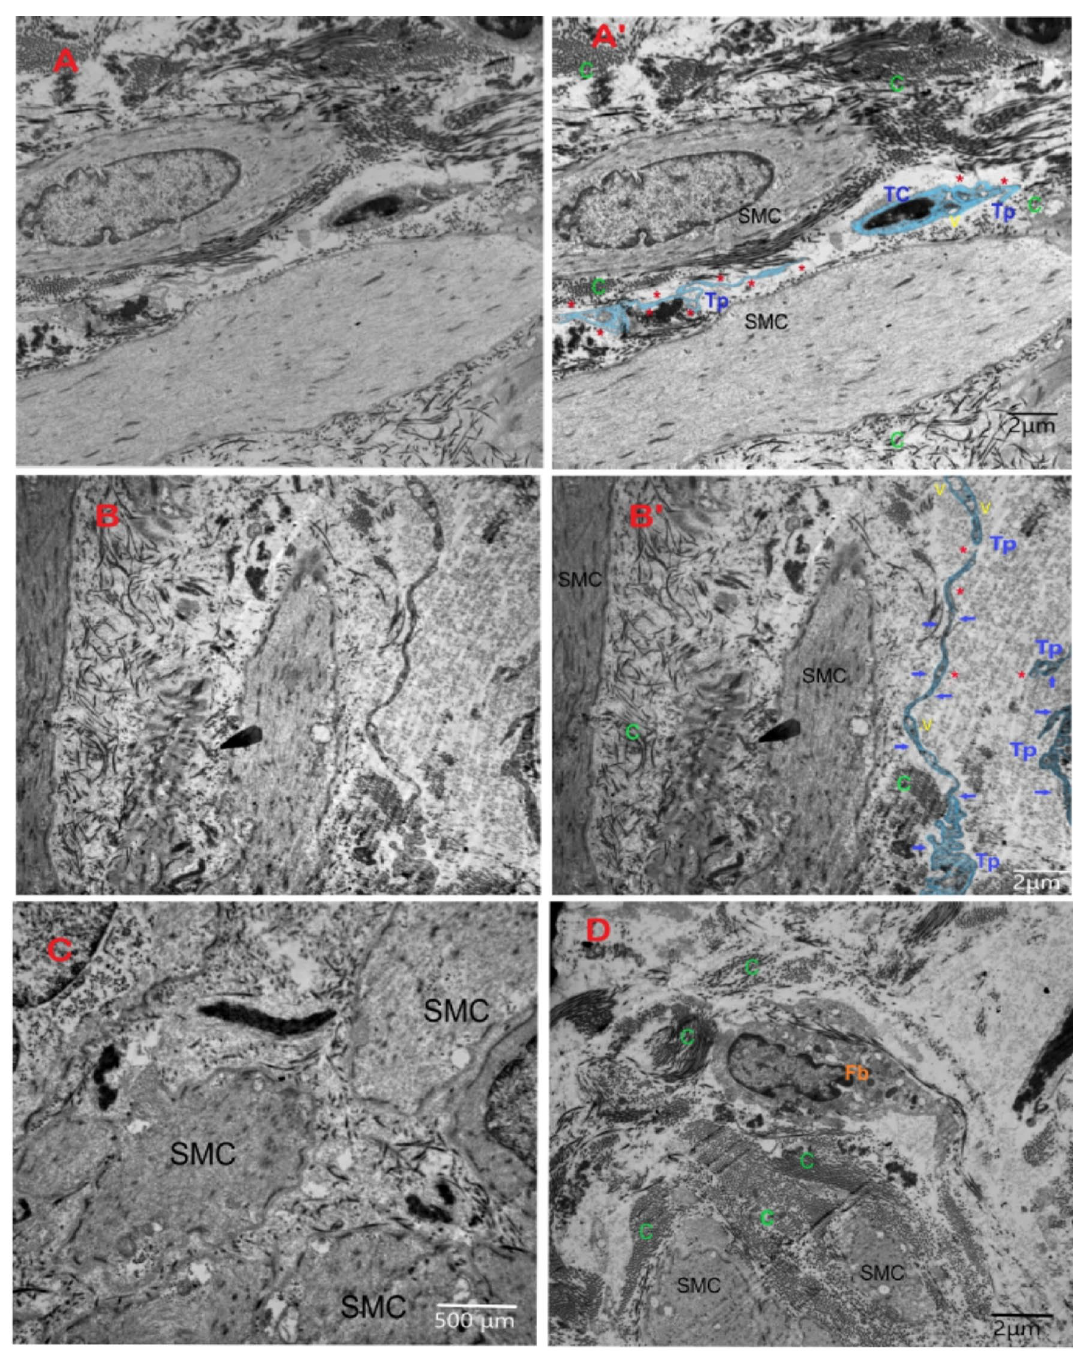
Figure 4. TEM microgram of submucosa and muscularis propria of normal-appearing tissue of urinary bladder with NMIBC. (A , A ′ ) ( A : original findings), ( A’ : digitalized image) showing TC with its distinct nucleus, and Tp (red Asterix) appearing thin, tortuous, and having numerous vesicles (V). TC and Tp are insinuated between two smooth muscle cells (SMC) and abundant collagen (green C). (Scale bar 2 μm). (B , B ′ ) (B: original findings), ( B ′ : digitalized image) showing Tp (blue short arrows and red Asterix) that has numerous vesicles (yellow V) and is attached to the smooth muscle cell (SMC) and collagen (green C). (Scale bar 2 μm). (C , D) showing smooth muscle cells (SMC) with condensation of collagen (c) between smooth muscle cells (SMC), and fibroblast cell (Fb) in close contact. No TCs or Tps were found. (Scale bar C:500 nm, D:2